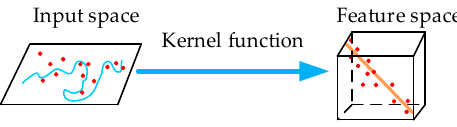
Figure 3. The principle of LSSVMs (least squares support vector machine).